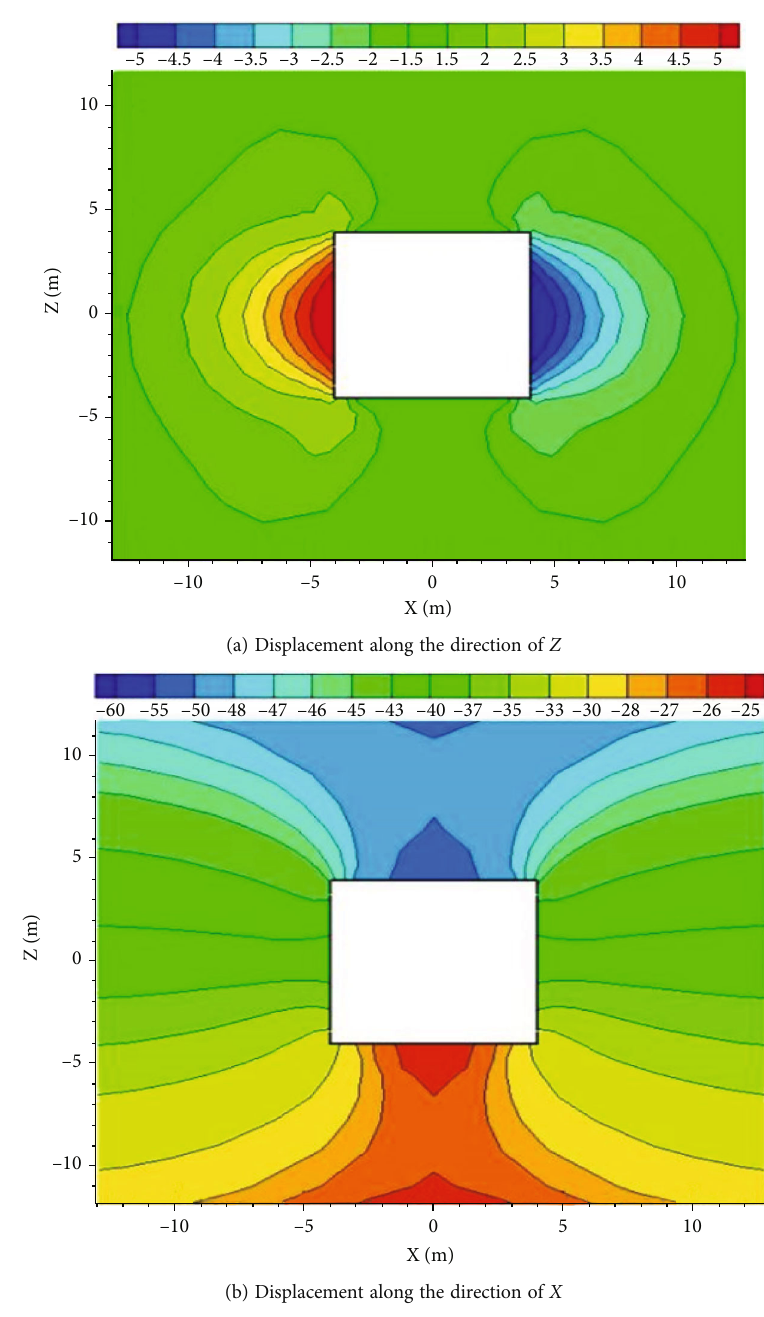
Figure 6: Contour of the displacement for the